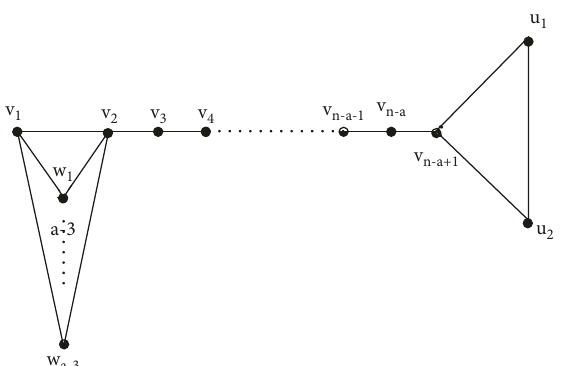
Figure 7: A graph with sm ( G ) � a,sm